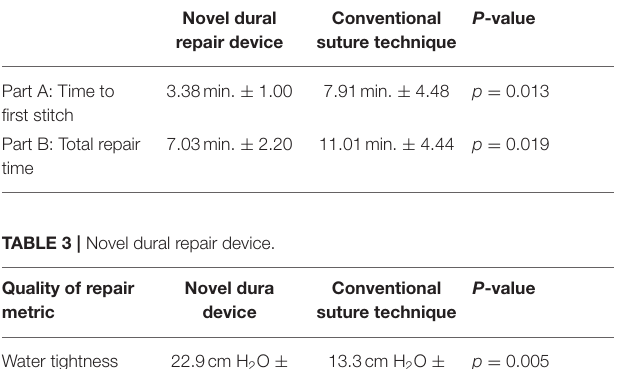
TABLE 2 | Repair time.